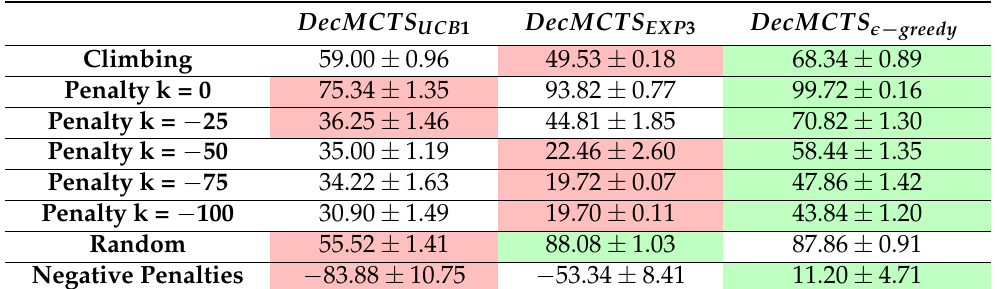
Figure 7. The average cumulative reward over the action selection policy parameters: (cid:101) and γ in Penalty k = 100 repeated game matrix. The whiskers show the standard error. − Table 1. The performance of decoupled-MCTS with different action selection